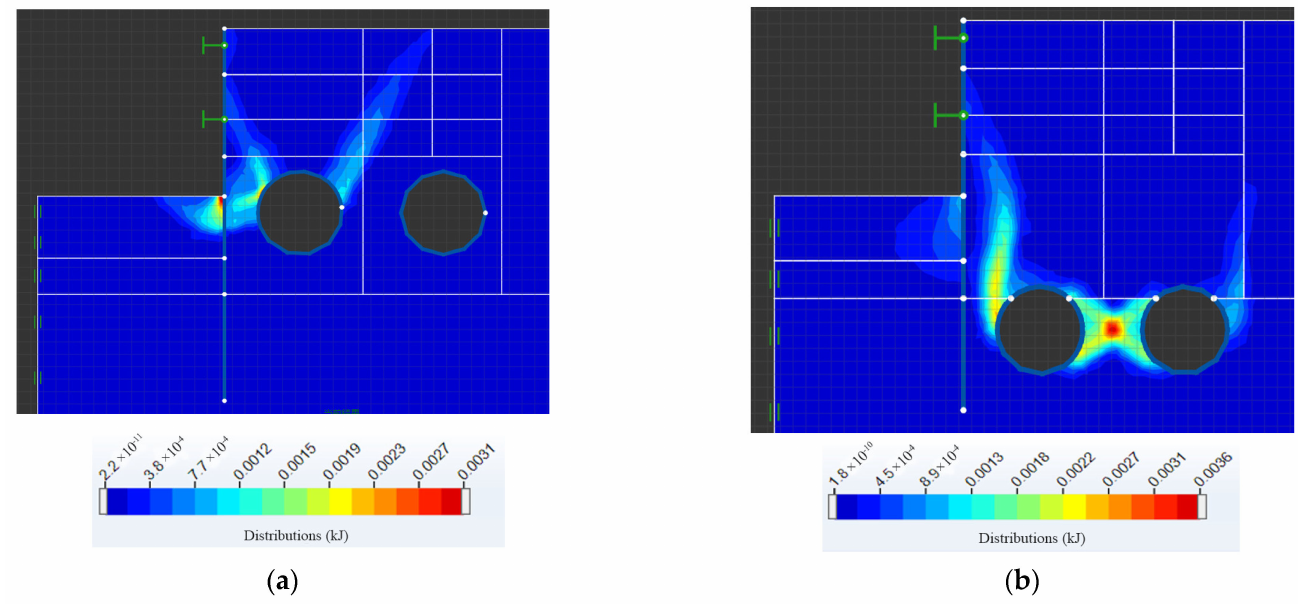
Figure 20. Shear dissipation contours under different cover depth C of the twin shield tunnels in stage (3): ( a ) C = 0.5 H and ( b ) C = 1.0 H.